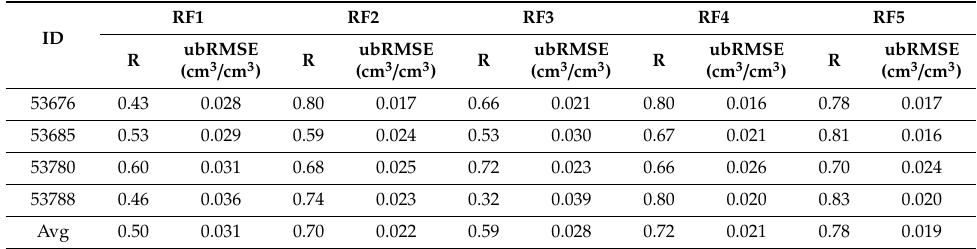
Table 3. Results comparison summary for the 1 km downscaled SM based on RF1–RF5 vs. in situ SM. The number of samples at stations 53676, 53685, 53780, and 53788 is 22, 21, 20 and 20, respectively. Avg is short for average.